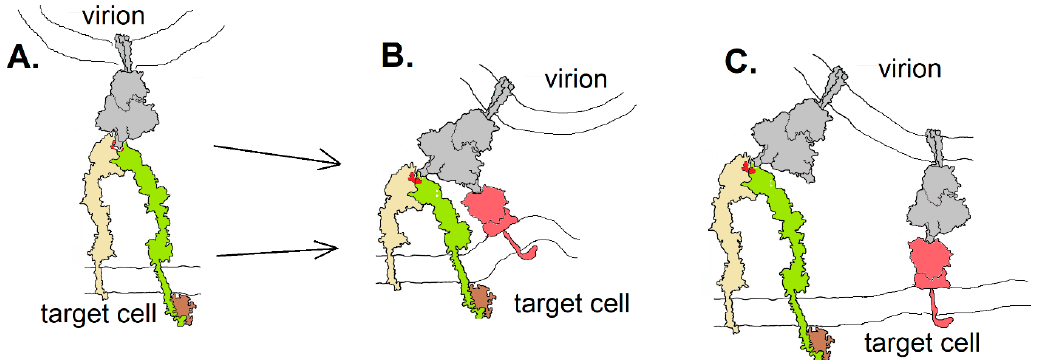
Figure 7. Three hypothetical modes of spike protein (gray) binding to integrin (yellow and green): ( A ) in an ACE2-independent way; ( B ) as a co-receptor in which a single spike protein interacts with both integrin and ACE2 (red) as facilitated by the flexibility of the receptor binding domains; ( C ) as a co-receptor in which multiple spike proteins interact with either an integrin or ACE2. Integrin drawing based on PDB Molecule of the Month (https://pdb101.rcsb.org/motm/134).